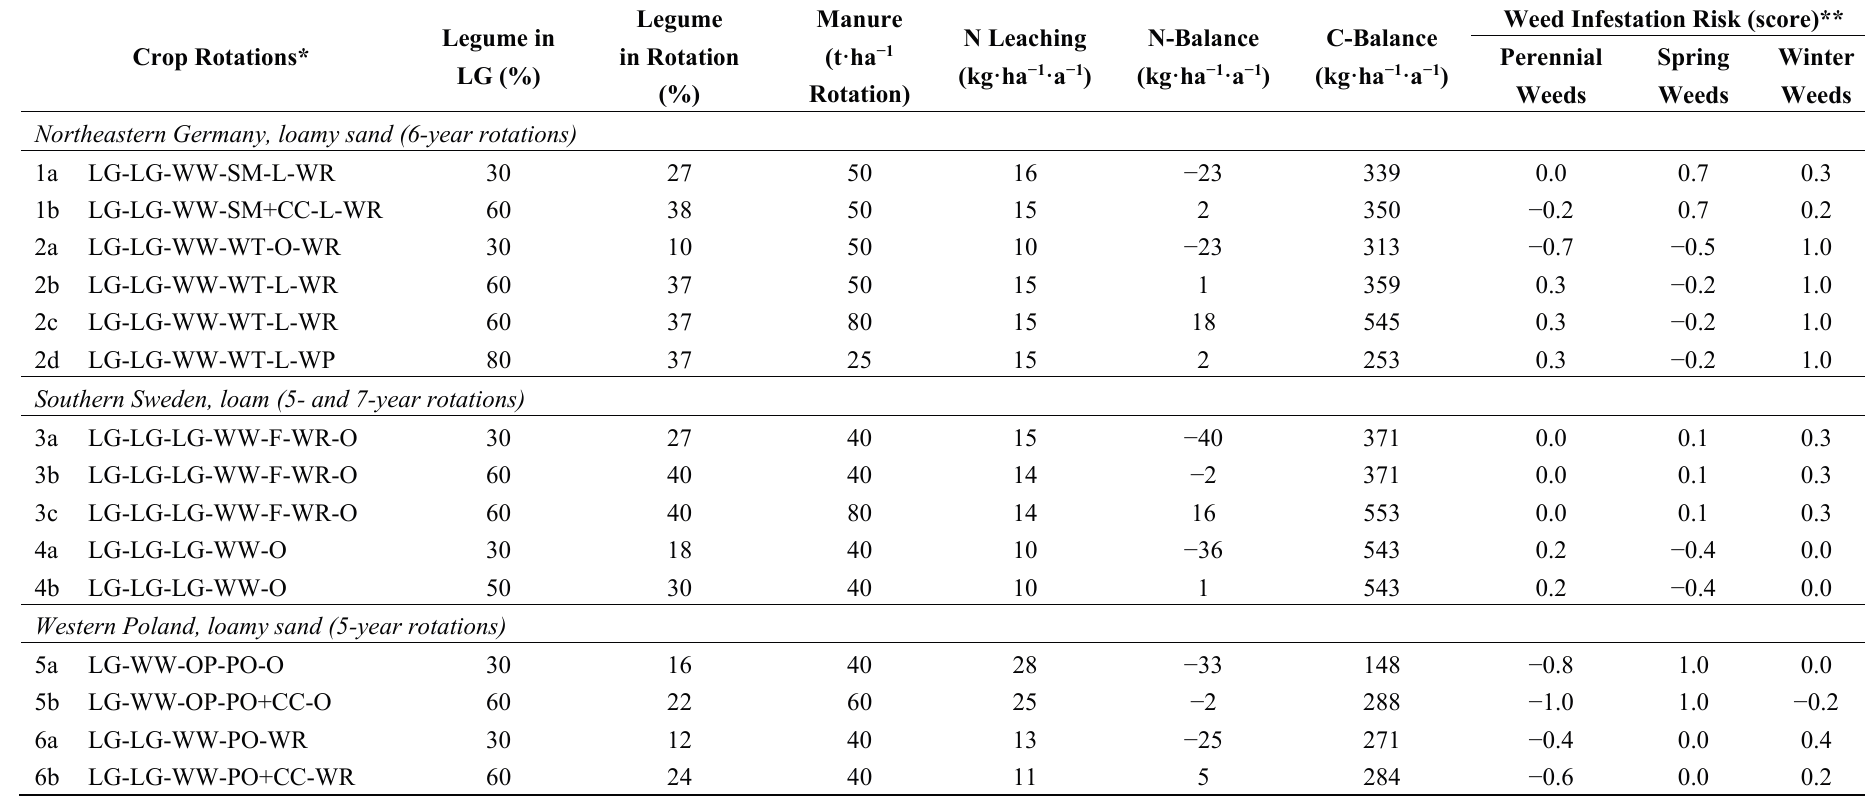
Table 4. Crop rotations and optimization strategies assessed with the crop rotation planning tool